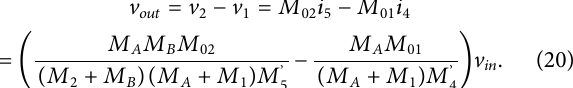
FIGURE 7 | Curve of memristance of M 5 with V set in variable width. When S 1 isonand S 2 , 3 off,thememristance of M 5 startstoreduceuntil R off or S 1 is turned off in